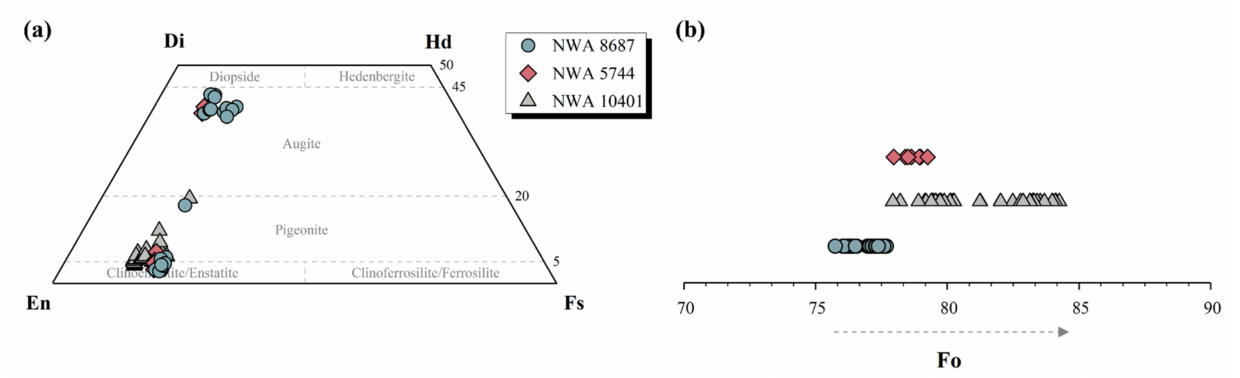
Figure 5. Pyroxene ( a ) and olivine ( b ) composition for NWA 8687, compared with a counterpart from pairs NWA 5744 and NWA 10401 [15,32]. Di—diopside, Hd—hedenbergite, En—enstatite, Fs—ferrosilite, and